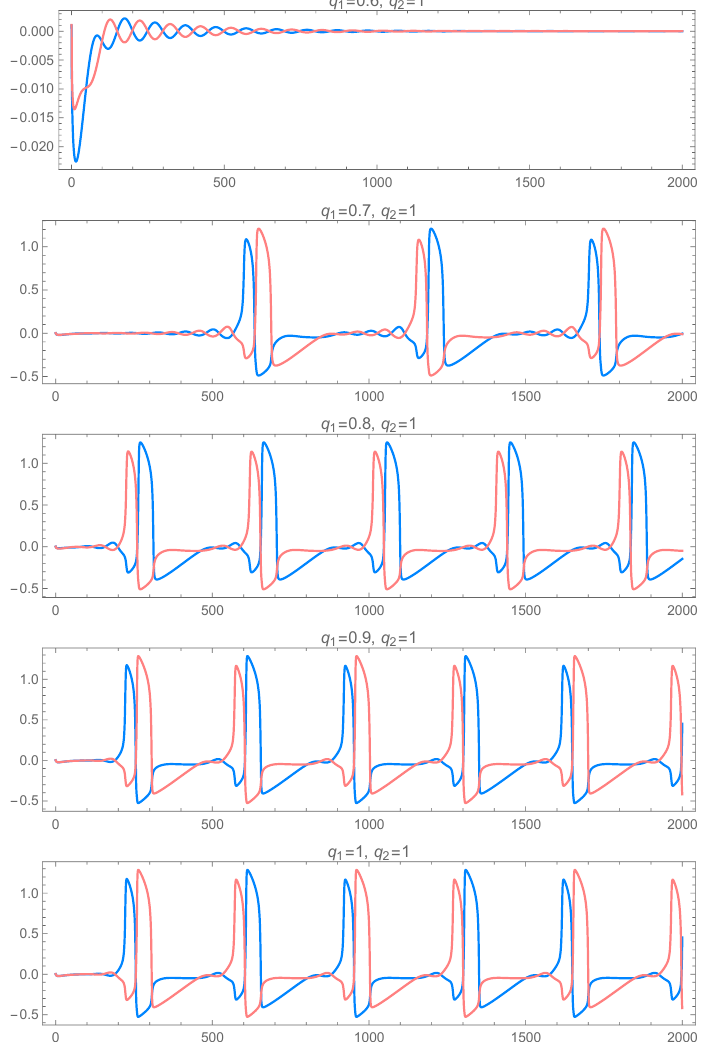
Figure 2. Evolution of the membrane potentials v 1 (blue) and v 2 (red) of the two neurons, for fixed parameter values a = 0.3, (cid:101) = 0.01 and β = 0.1, coupling coefficient g = 0.2, fixed fractional order q 2 = 1 and q 1 ∈ { 0.6,0.7,0.8,0.9,1 } (top to bottom). Initial conditions for system (3) have been chosen in a neighborhood of the trivial